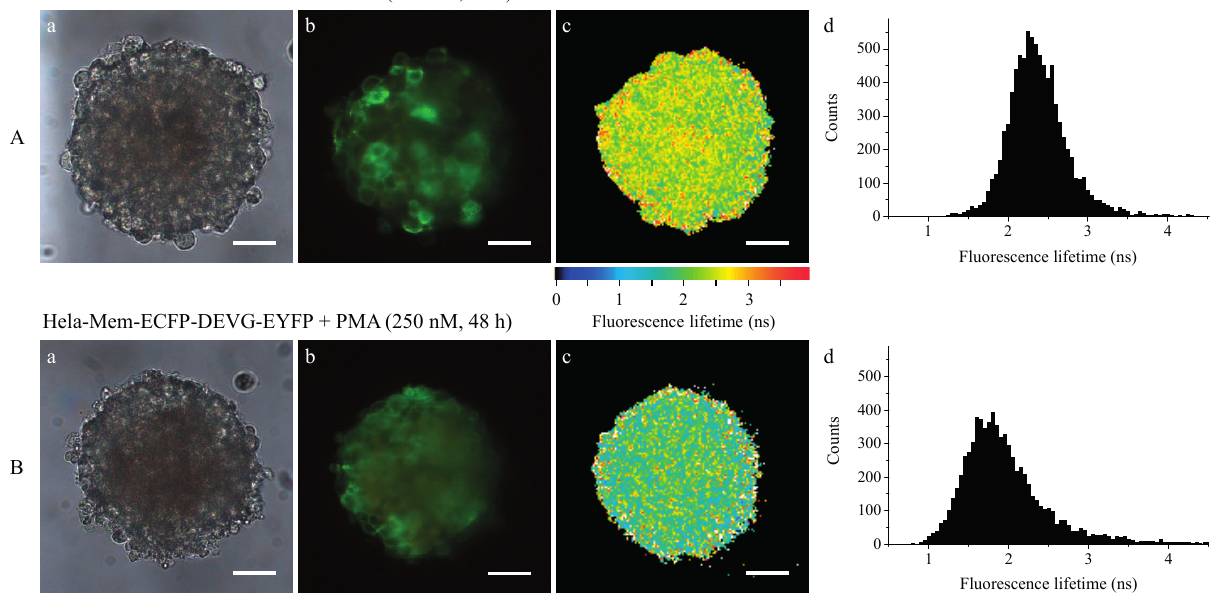
Figure 6. Transillumination ( a ), fluorescence intensity ( λ ≥ 515 nm); ( b ) and fluorescence lifetime (450–490 nm); ( c ) including histograms; ( d ) of HeLa cervical carcinoma cells expressing Mem-ECFP-DEVD-EYFP ( A ) or Mem-ECFP-DEVD-EYFP ( B ) after application of phorbol-12-myristate-13-acetate (PMA) (250 nM, 48 h). Light sheet based fluorescence microscopy of individual layers of a multicellular spheroid with 6–10 µm thickness each. Excitation wavelength: 391 nm. Scale bars: 50